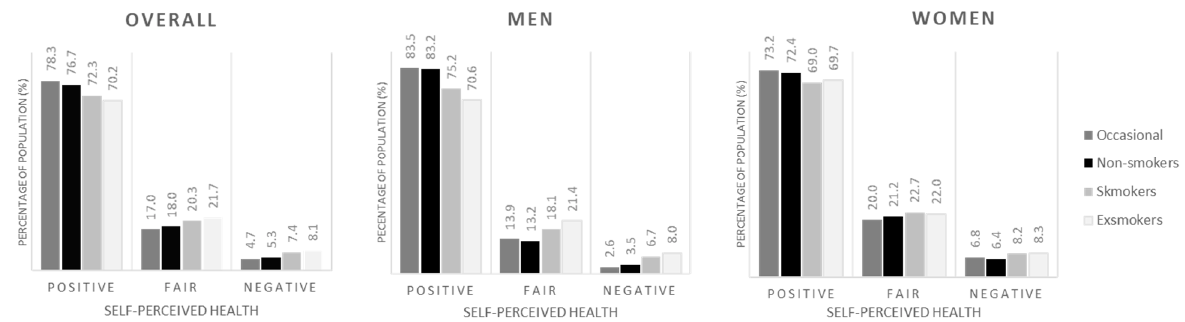
Figure A2. Level of physical activity in the general Spanish population and according to sex.